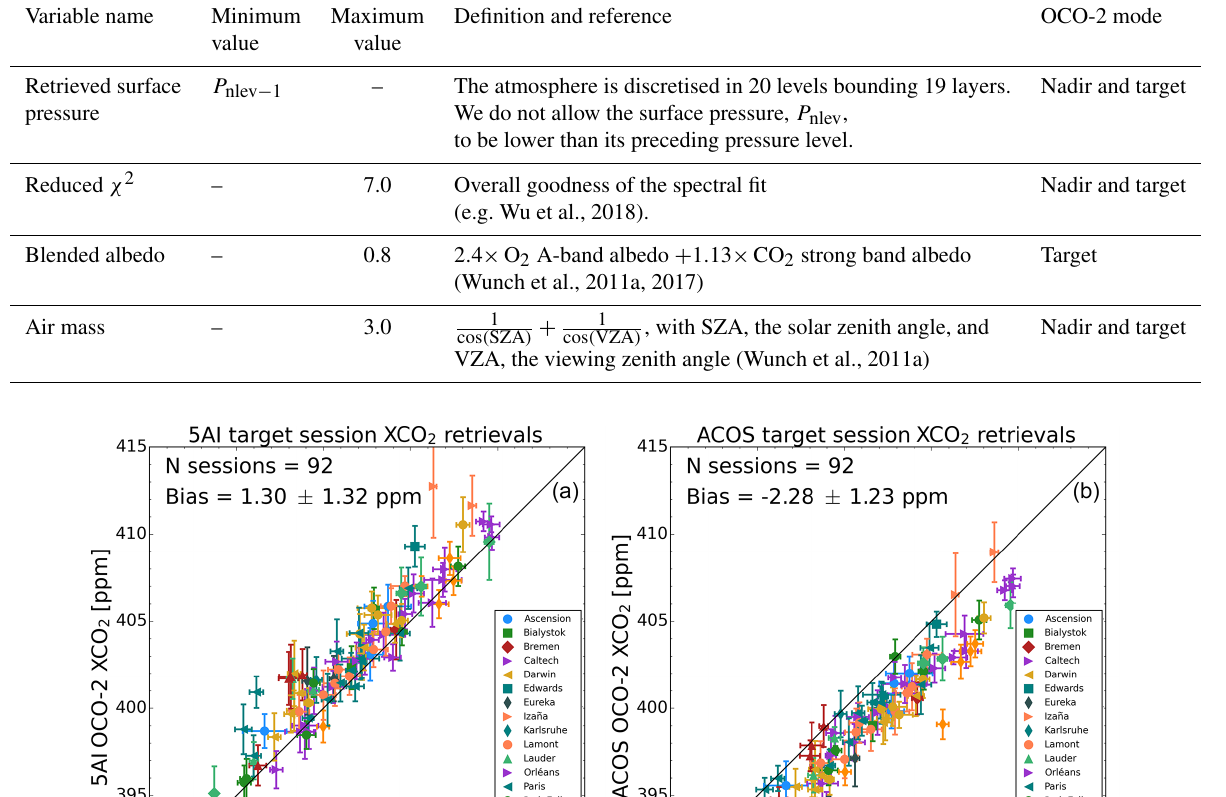
retrieval results compared to the TCCON official X CO 2